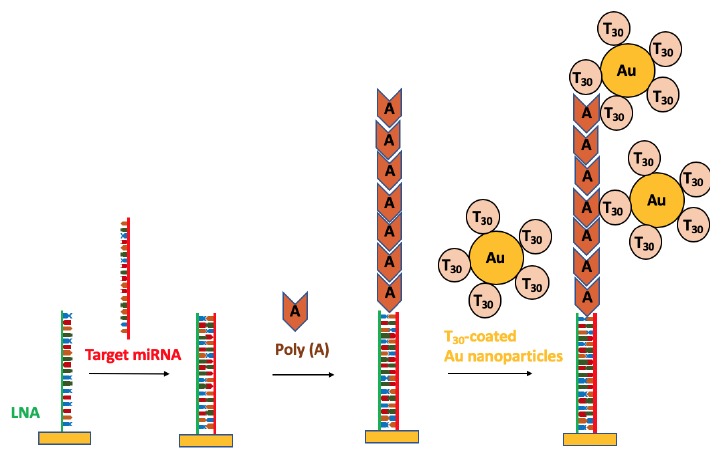
Figure 8. miRNAs detection mechanism using a combination of surface polyadenylation chemistry and nanoparticle amplified SPRi detection.